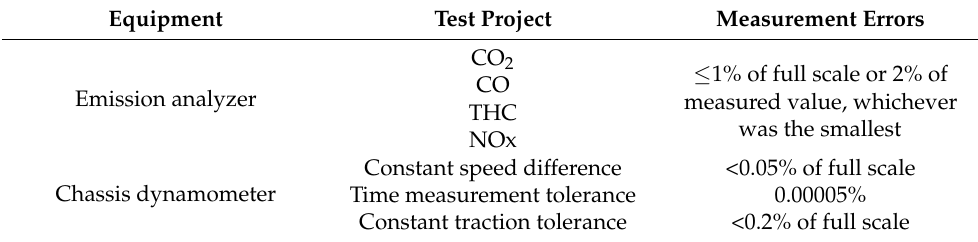
Table 3. The measurement errors of the main test equipment.